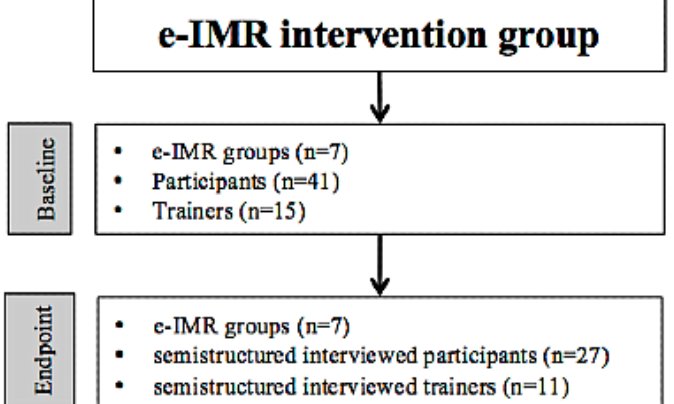
Figure 1. Study flow diagram. e-IMR: electronic Illness Management and